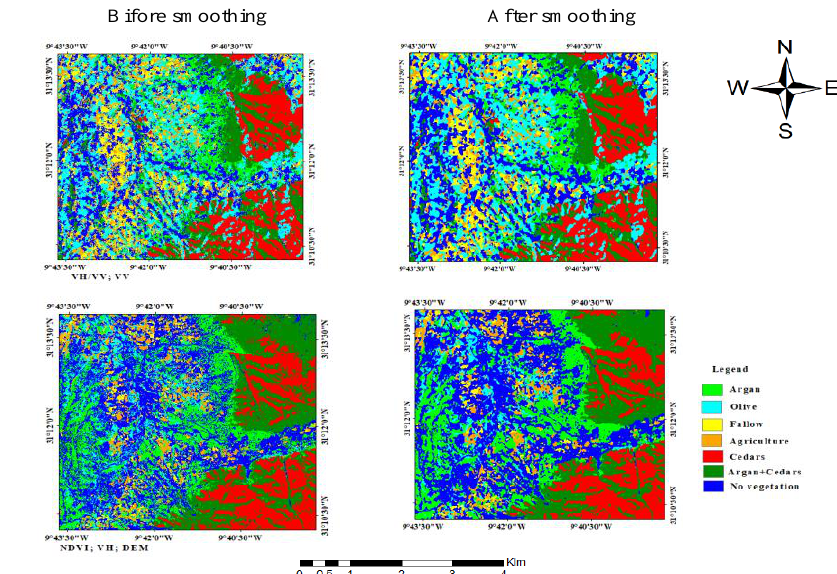
Figure 5 . Smoothing of scenario classification (NDVI; VH;